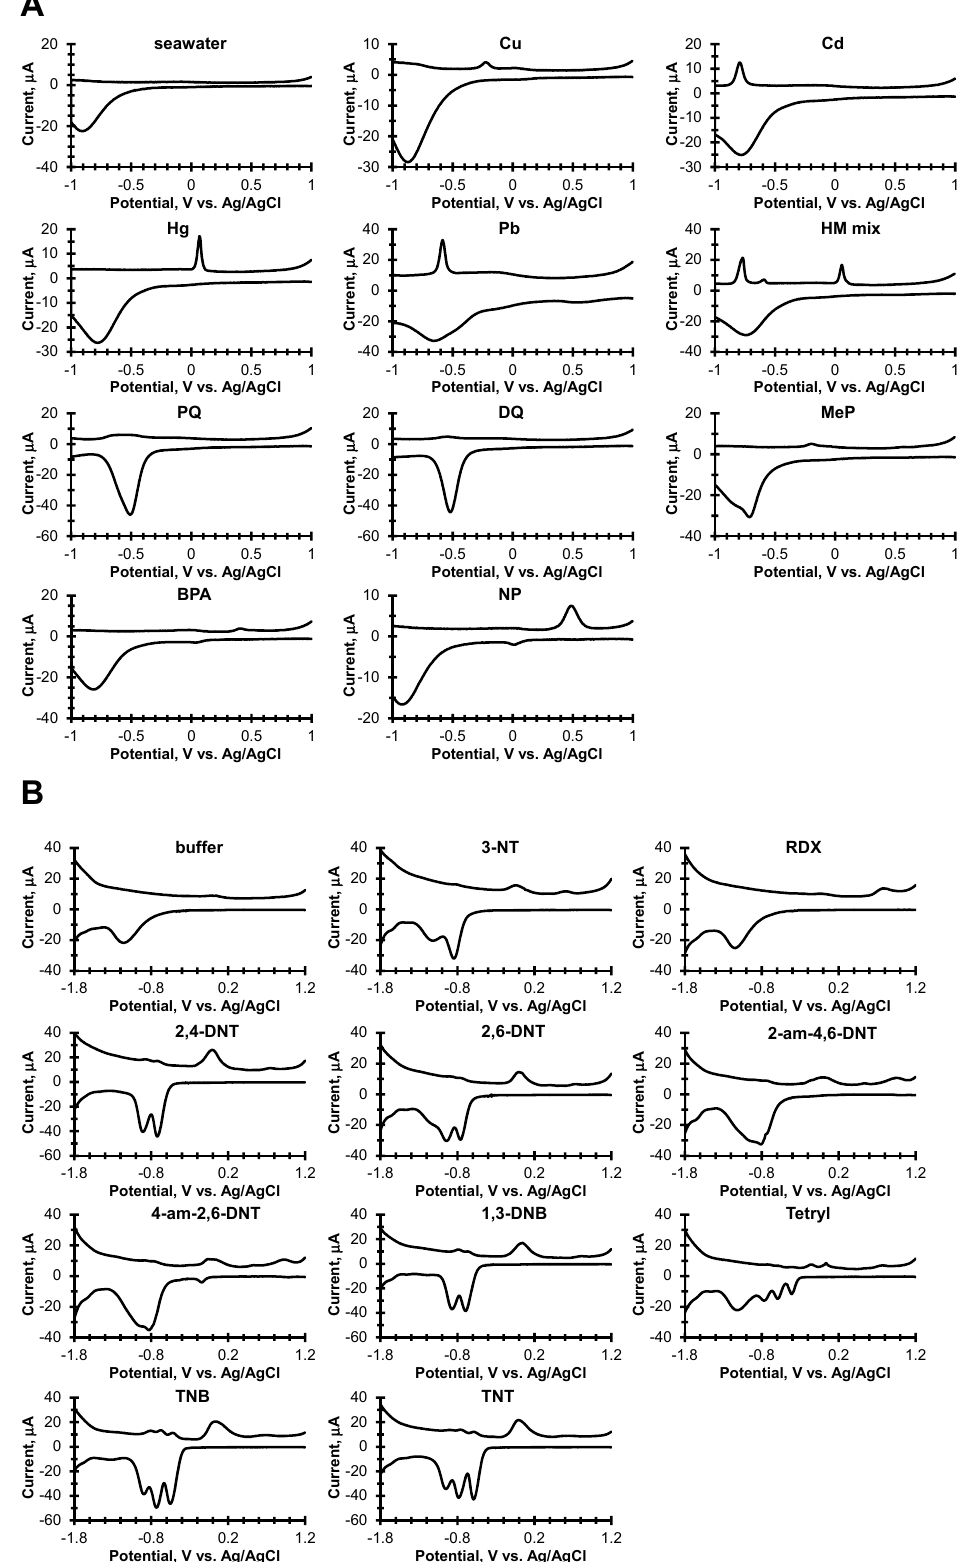
Figure 1 . Electrochemical signatures for each compound. ( A ) Chemicals in seawater. ( B ) Explosives in buffer from reference [8].